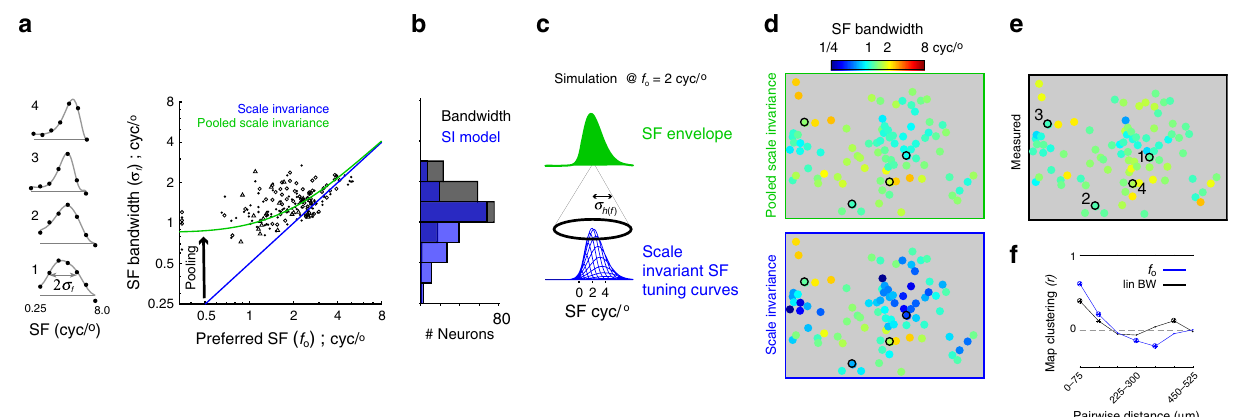
Fig. 5 SF bandwidth as a function of preferred SF ( f o ). a The scatter plot compares f o to SF bandwidth in three ROIs, each indicated by a different symbol. See Table 2 for joint statistics. The fi ve data points at the extreme left of the x -axis were low pass. Blue line is the scale invariance prediction of bandwidth, f y -axis are SF tuning curves (black dots) and fi ts (gray) of four example o /2. Green line is the model of pooled scale invariance (Eq. (7)). To the left of the cells in one ROI outlined and enumerated in e . b Distribution of the measured SF bandwidth (black) and the scale invariance prediction of SF bandwidth (blue). c Simulation of the pooling model in the spectral domain, at f o = 2 cyc/°. At the bottom are the 1D Gaussian functions from the model of scale invariance. They are shifted (cyc/°) and weighted according to the Gaussian in the pooling model ( σ h ( f ) = 0.85 cyc/°). The superposition of the scale invariant Gaussians yields the function on top, which is the output of the pooling model. d Predicted maps of SF bandwidth. Bottom and top panels are generated by plugging f o in to the scale invariance and pooled scale invariance model, respectively. e Map of measured SF bandwidth. f Pearson correlation coef fi cient between neural pairs, within 75 μ m cortical distance bins, using all three ROIs in the study. The symbol at each distance bin indicates the correlation coef fi cient ’ s signi fi cance: Closed dot is p > 0.01, asterisk is p < 0.01, asterisk and open circle is p <